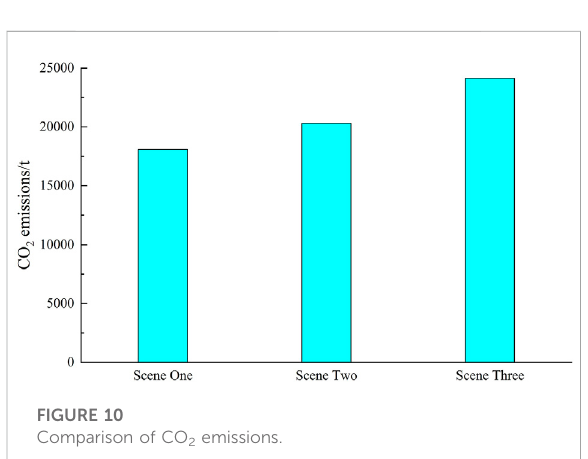
FIGURE 10 Comparison of CO 2 emissions.